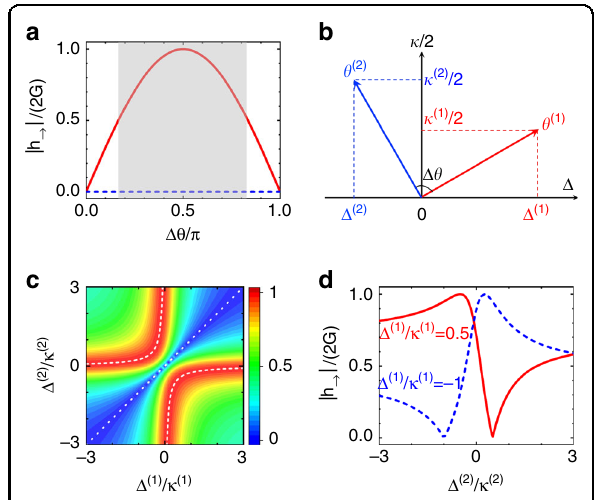
Fig. 3 Optimization of the unidirectional forward coupling amplitude. a Unidirectional forward coupling amplitude j h ! j (red solid curve) vs. Δ θ under the condition of Δ ϕ ¼ ± Δ θ þ π þ 2 k π . The backward coupling amplitude j h j is 0 (blue dashed curve). b Sketch of the loss phase difference Δ θ in the detuning-loss coordinate system. c Contour plot of j h ! j as a function of Δ ð 1 Þ = κ ð 1 Þ and Δ ð 2 Þ = κ ð 2 Þ . The white dashed curves correspond to the optimal conditions given in Eq. (3), whereas the white dotted curve represents the reciprocal case ( Δ ð 1 Þ κ ð 2 Þ ¼ Δ ð 2 Þ κ ð 1 Þ ). d j h ! j vs. Δ ð 2 Þ = κ ð 2 Þ for Δ ð 1 Þ = κ ð 1 Þ ¼ 0 : 5 (red solid curve) and (cid:2) 1 (blue dashed curve)